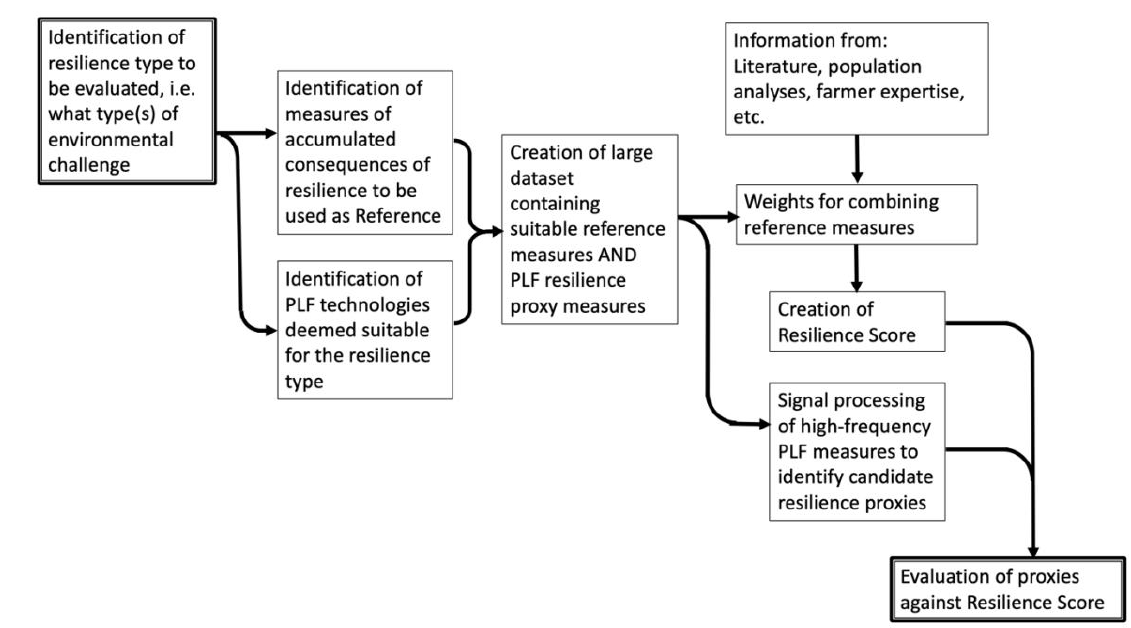
Figure 4: Schematic representation of the process for developing operational proxies of resilience that have been validated against reference measures of the long-term, accumulated, consequences of differences in